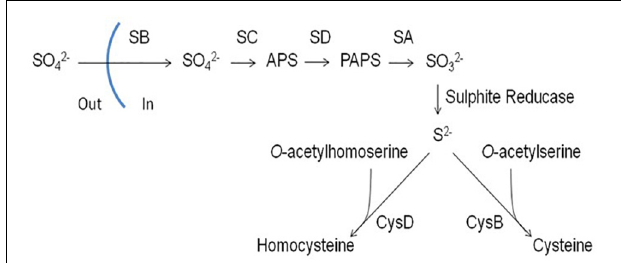
FIGURE 1 | Assimilation of inorganic sulfur (sulfate) in filamentous fungi. SB , sulfate permease; SC , ATP sulphurylase; SD , adenosine 5 (cid:48) -phosphosulphate (APS) kinase; SA , 3 (cid:48) -phosphoadenosine-5 (cid:48) -phosphosulphate (PAPS) reductase; CysB , cysteine synthase; CysD , homocysteine synthase (Amich et al.,